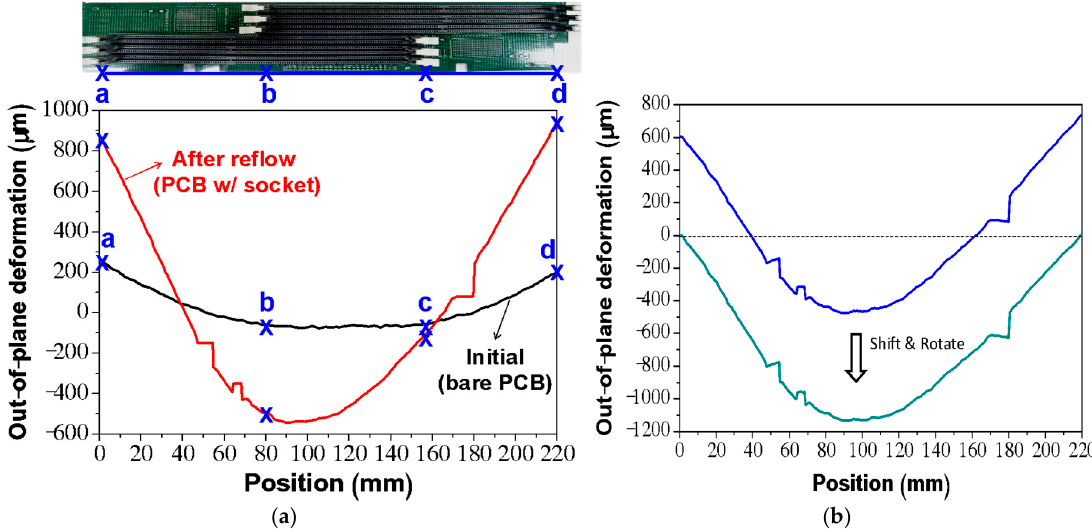
Figure 8. ( a ) Out-of-plane deformation of the bare PCB and PCB with DIMM sockets (after the reflow process) measured from shadow moiré, and ( b ) thermally-induced out-of-plane deformation of the PCB with DIMM sockets.